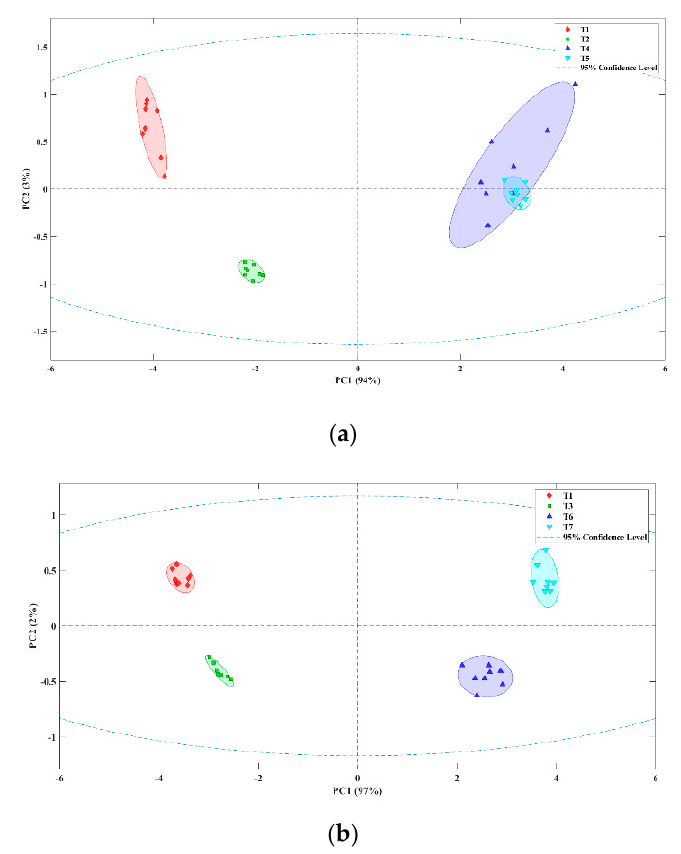
Figure 4. Score plot obtained from the PCA of Californian-style black olives prepared with fresh ( a ) and lyophilized ( b ) Carao and stuffed with flavoured hydrocolloids. T1: olives with ferrous gluconate stuffed with 0% of ‘Mojo picón’; T2: olives with fresh Carao stuffed with 0% of ‘Mojo picón’; T4: olives with fresh Carao stuffed with 2% ‘Mojo picón’; T5: olives with fresh Carao stuffed with 4% of ‘Mojo picón’; T3: olives with lyophilized Carao stuffed with 0% of ‘Mojo picón’; T6: olives with lyophilized Carao stuffed with 2% of ‘Mojo picón’; T7: olives with lyophilized Carao stuffed with 4% of ‘Mojo picón’. Table 4. Confusion matrix obtained through PLS-DA for discrimination between stuffed olives with flavoured hydrocolloids. Values are expressed in percentage.